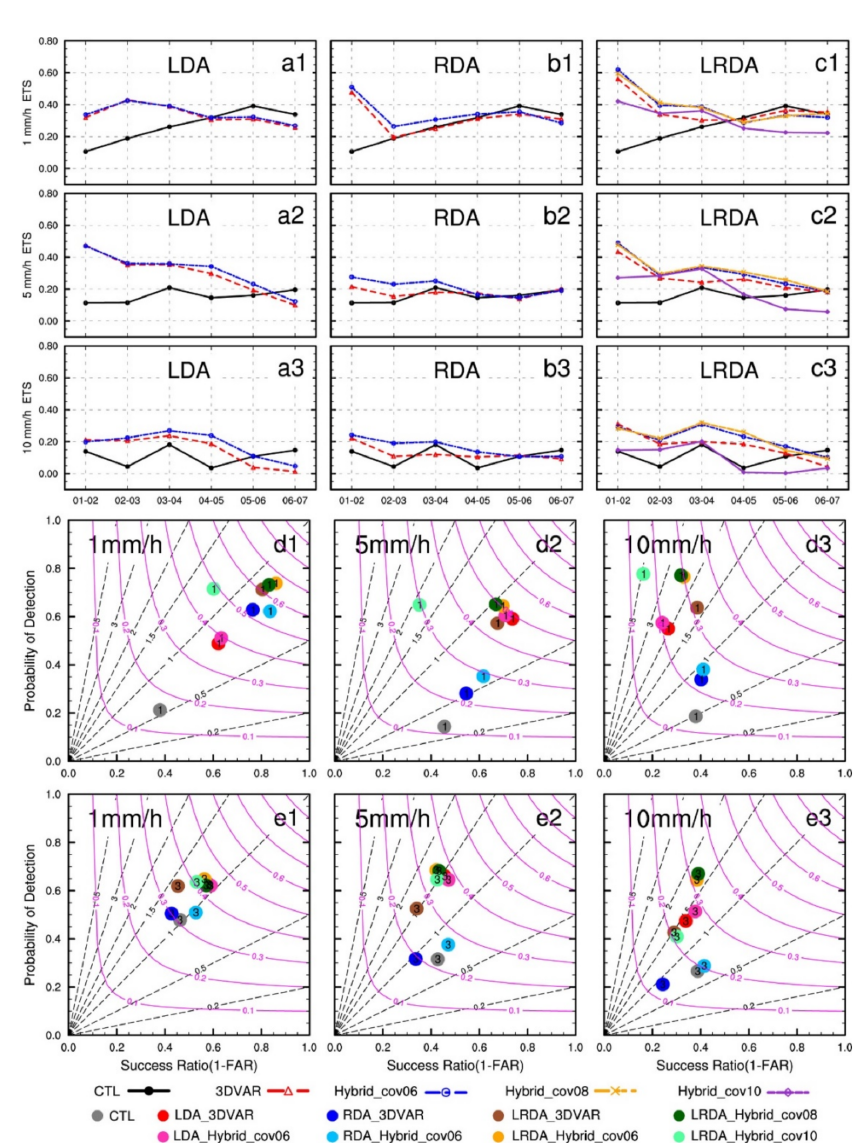
Figure 12. As in Figure 9, but for the cycling analysis experiments. ( a1 – a3 ) the lightning data assimilation experiments (LDA), ( b1 – b3 ) the radar data assimilation experiments (RDA), ( c1 – c3 ) the combined lightning and radar data assimilation experiments. ( a1 , b1 , c1 , d1 , e1 ) the 1 mm threshold, ( a2 , b2 , c2 , d2 , e2 ) the 5 mm threshold, ( a3 , b3 , c3 , d3 , e3 ) the 10 mm